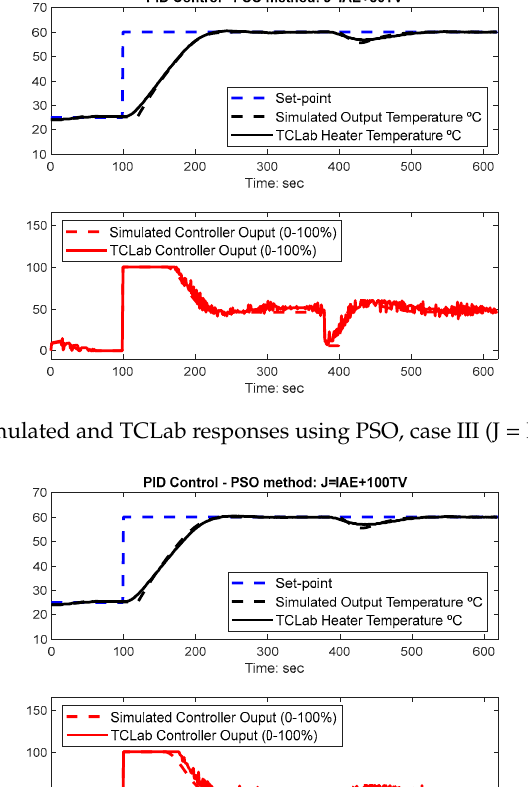
Figure 16. Simulated and TCLab responses using PSO, case IV (J = IAE + 100 TV).